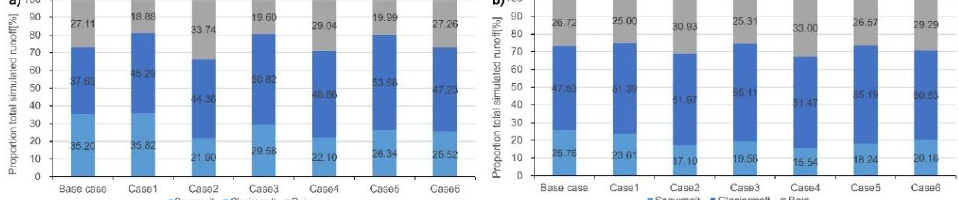
Figure 12. Comparison of runoff components during the calibration (a) and validation (b) periods for the seven cases.